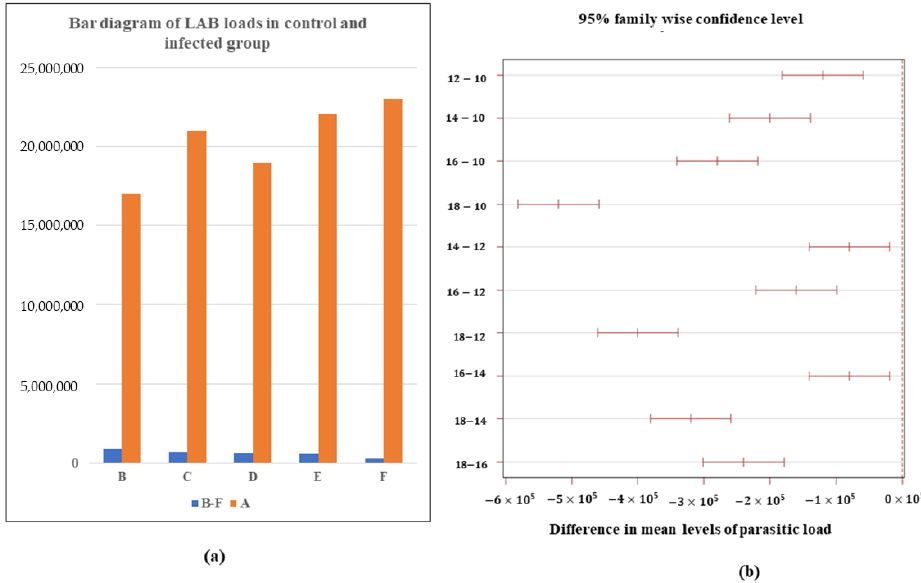
Figure 1. LAB load in rats: ( a ) Comparison between control (Group A) and infected rats (Group B, C, D, E and F with 10, 12, 14, 16 and 18 parasites) Each Group n = 6; ( b ) Tukey’s honest significant test showing significance of differences of LAB load between pairs of Group means (12–10, 14–10, 16–10, 18–10, 14–12, 16–12, 18–12, 16–14, 18–14, and